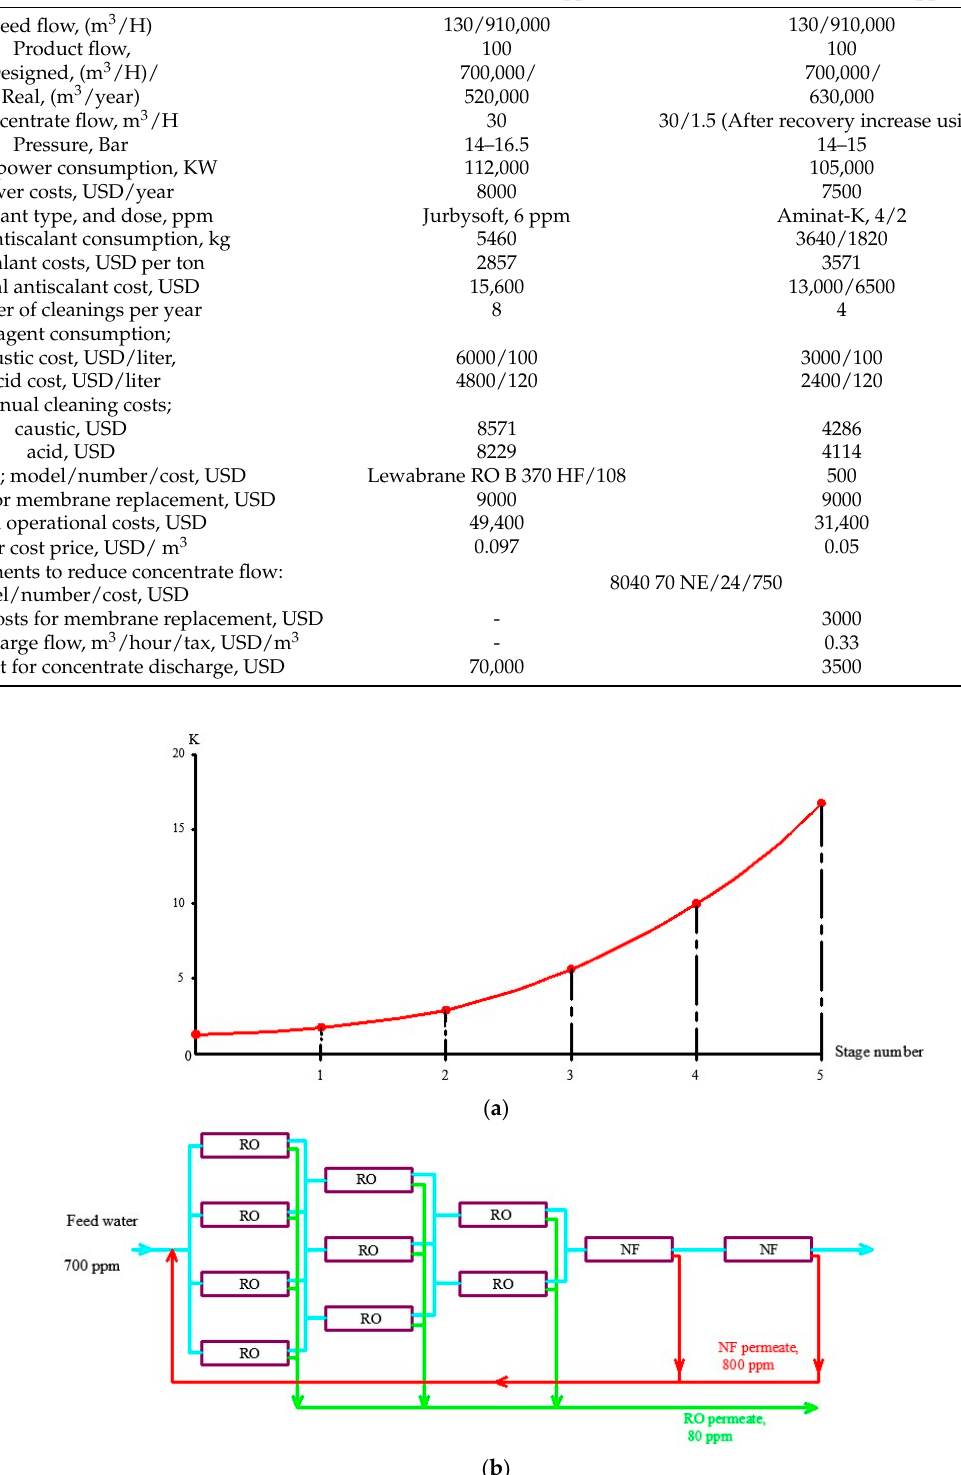
Figure 9. Evaluation of K values in membrane elements of the RO plant array: ( a ) dependencies of K values on the membrane stage number; ( b ) pressure vessels array in membrane plant.